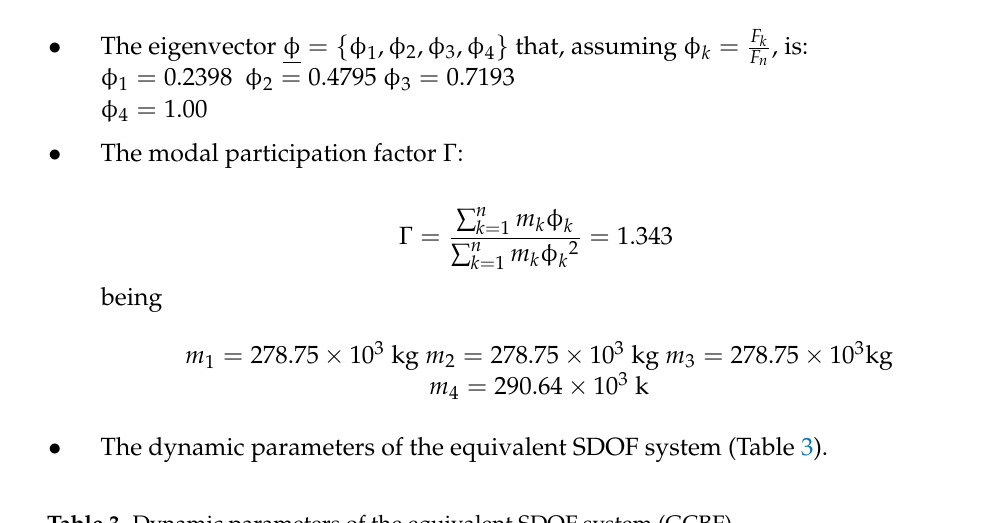
Table 3. Dynamic parameters of the equivalent SDOF system (GCBF).